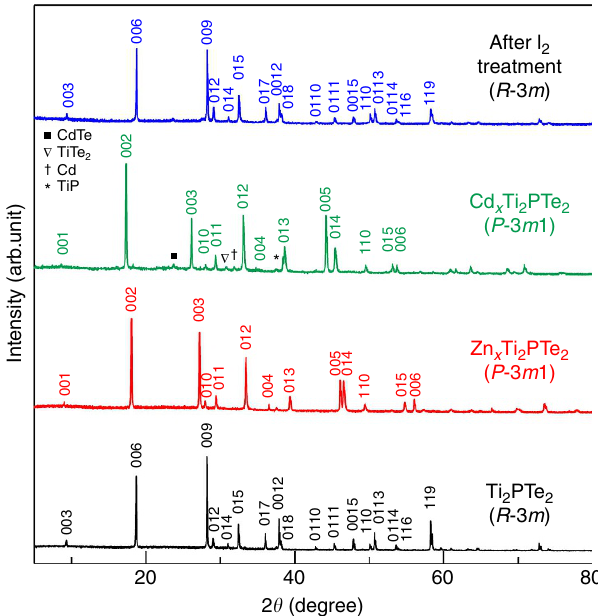
Figure 2 | X-ray diffraction patterns of Ti 2 PTe 2 and (de)intercalated materials. From bottom to top: Ti 2 PTe 2 , Zn x Ti 2 PTe 2 (300 (cid:2) C, 48h, p ¼ 0.4), Cd x Ti 2 PTe 2 (200 (cid:2) C, 48h, p ¼ 0.4), deintercalated product after I 2 treatment of Zn x Ti 2 PTe 2 at room temperature. Peaks with symbols show tiny amount of impurity phases (CdTe, TiTe 2 and so on) for Cd intercalation.